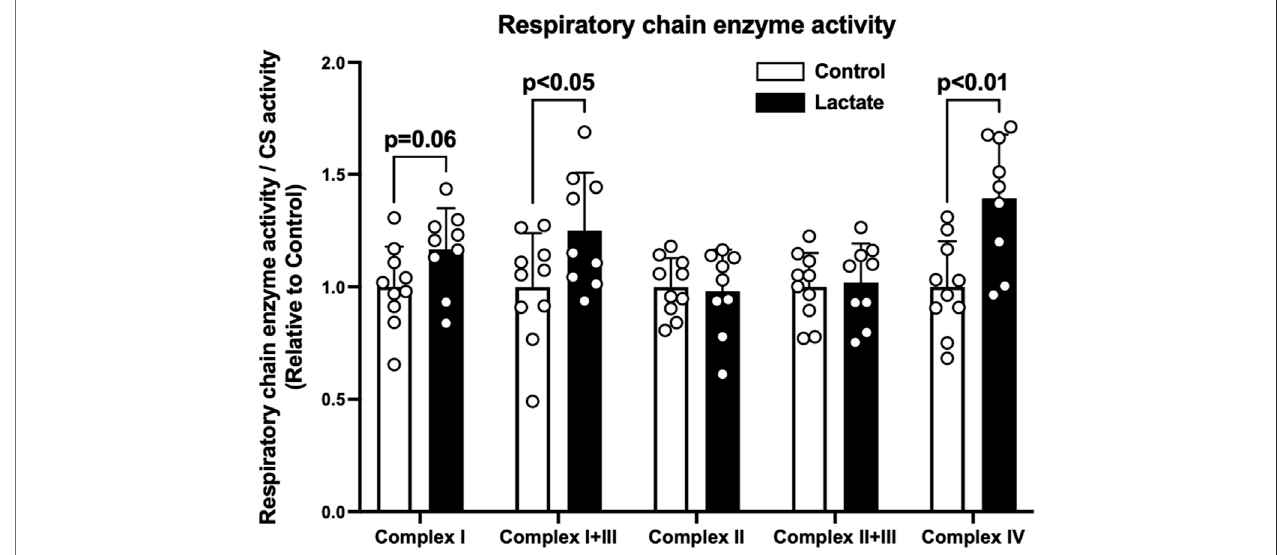
FIGURE 2 | Mitochondrial respiratory chain enzyme activity. Data are expressed as mean ± SD and are normalized to citrate synthase (CS) activity. Control group: n = 10, Lactate group: n = 9. Unpaired Student ’ s t-test was used for statistical evaluation.